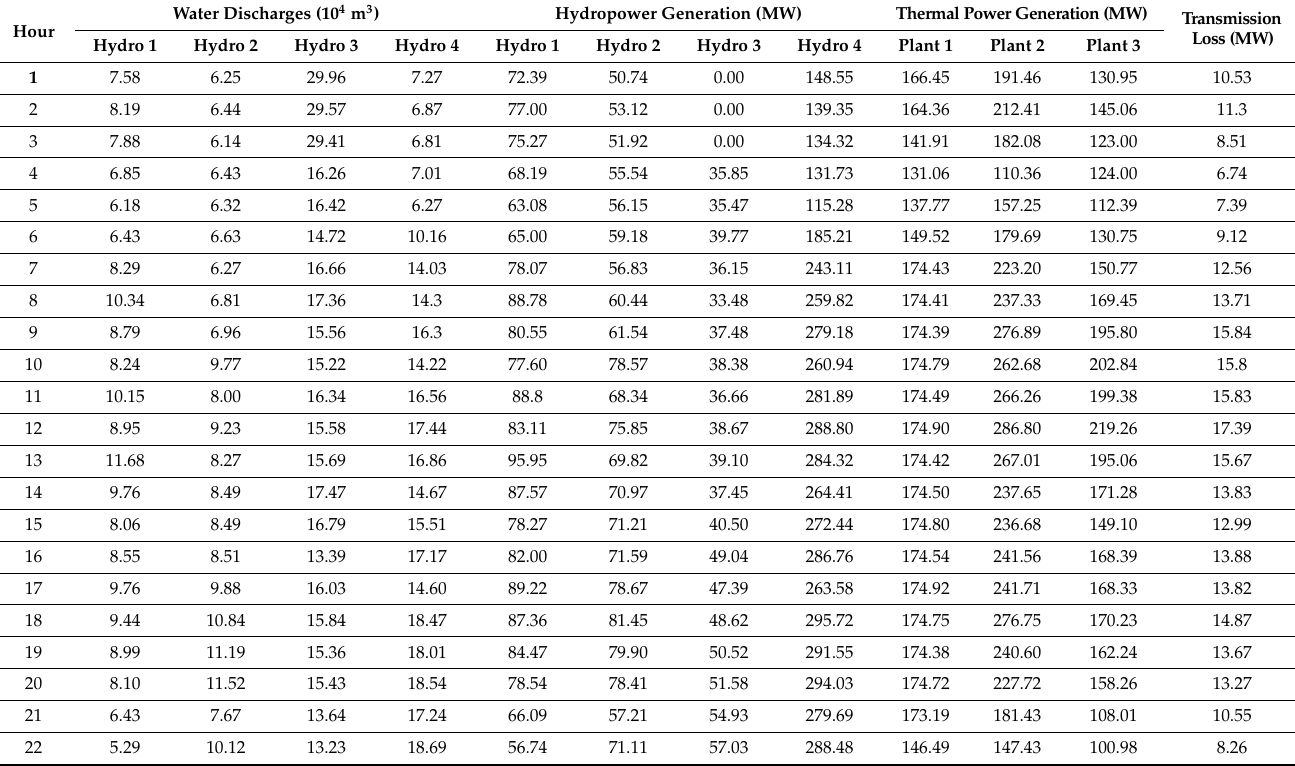
Table 8. EEP minimization schedule results of DOGSA for Test